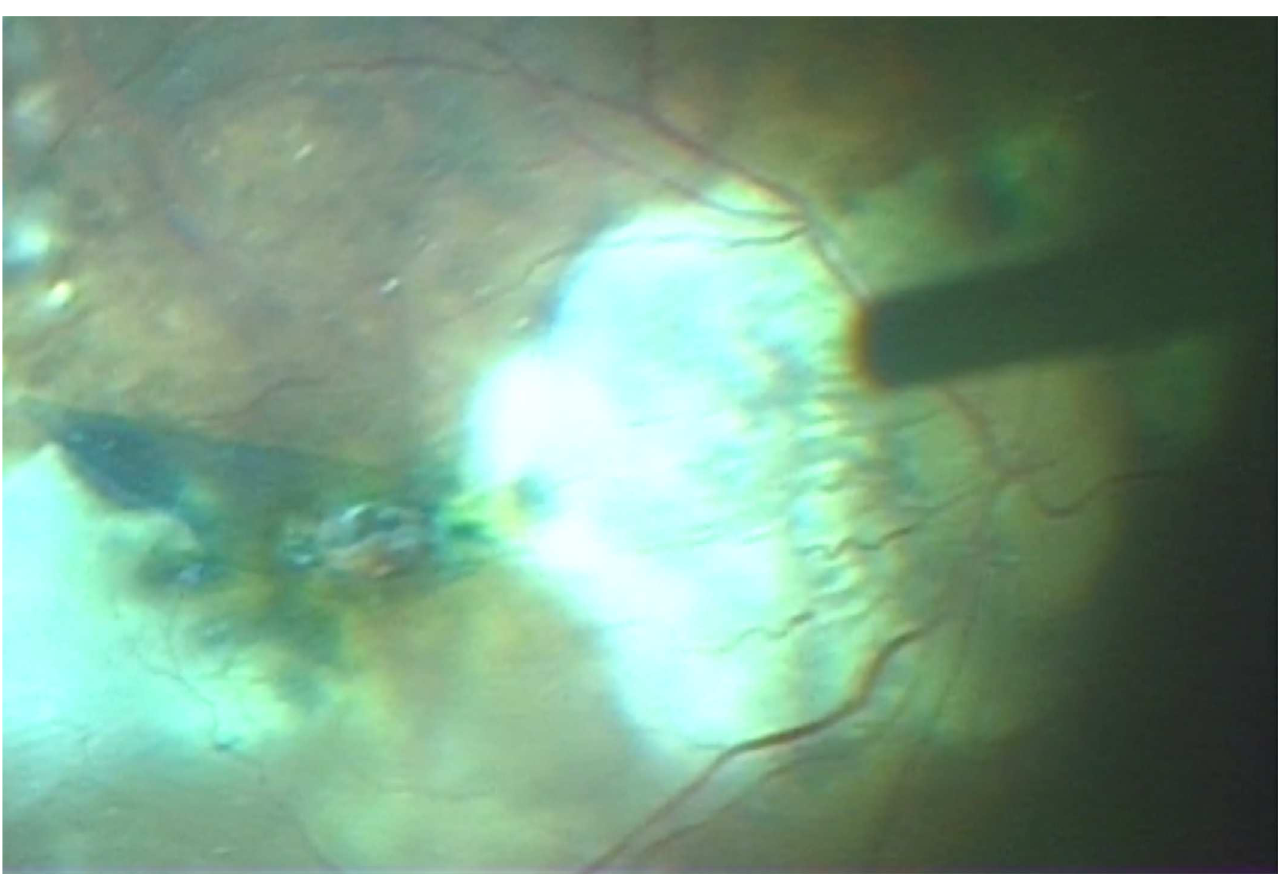
Fig 1. Surgical photograph of the inverted internal limiting membraneflap around the macular hole-associated retinal detachment. After brilliantblue G staining, the internallimiting membrane was peeledand inverted to cover the macular